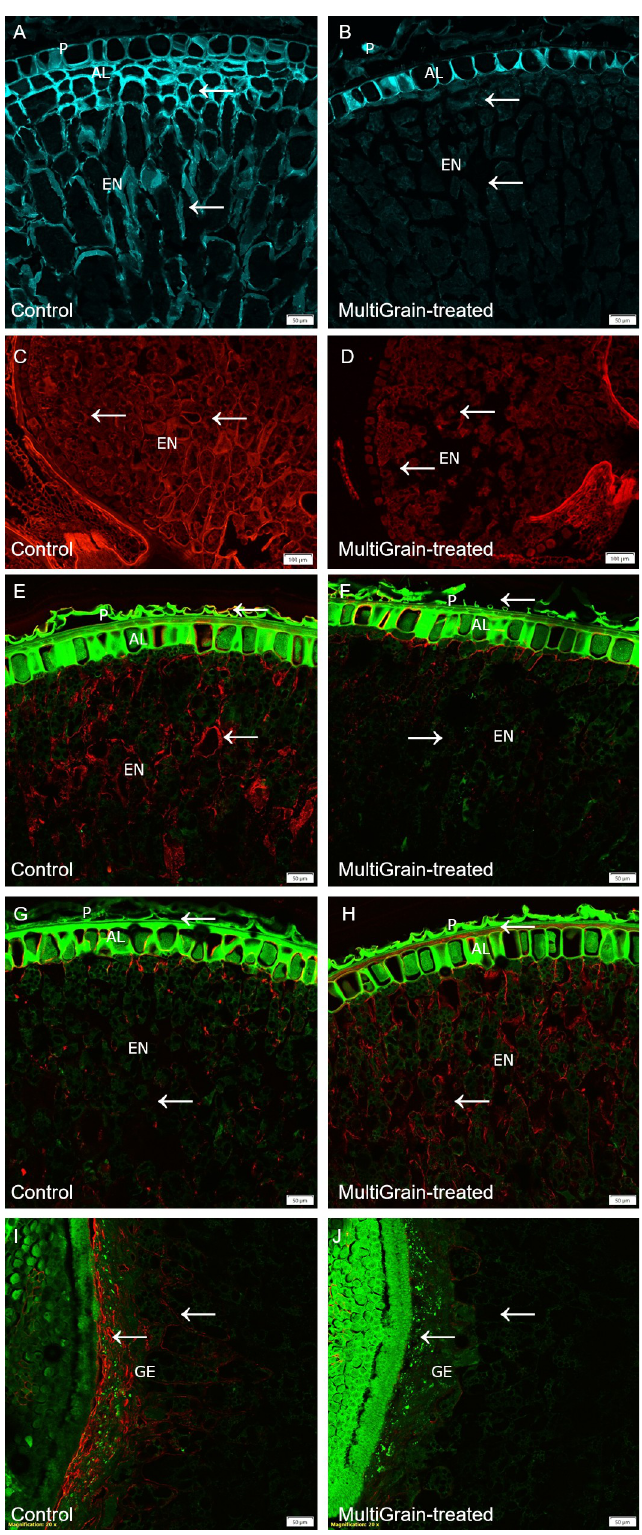
Fig 4. Confocal images of cross sections of whole rye grains. Section of samples incubated (A, C, E, G, I) with sodium acetate buffer (control) or (B, D, F, H, J) with MultiGrain for 3 hours at pH 5. The sections were